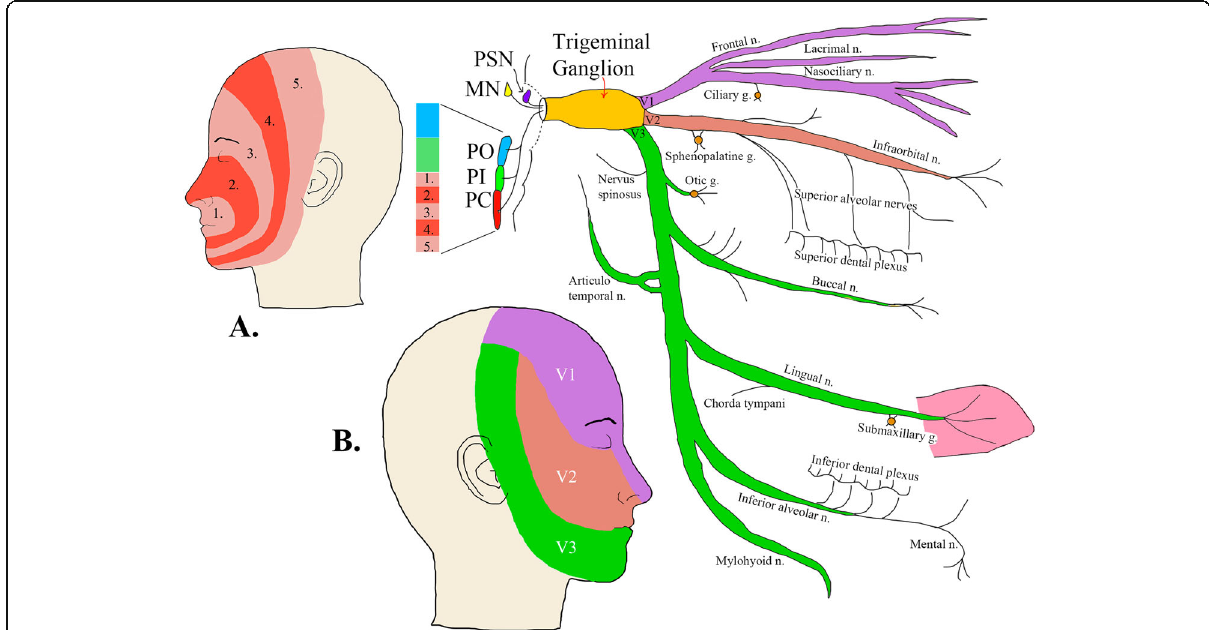
Fig. 1 Schematic of the Trigeminal System. a : The somatotopic distribution of trigeminal nociceptive afferents terminating in the trigeminal nucleus caudalis [11]. b : Innervation of facial skin areas and its related three branches (V1, V2 and V3). PSN (Principal sensory nucleus CN V), MN (Mesencephalic nucleus CN V), PA (Spinal nucleus of CN V Pars Oralis), PI (Spinal nucleus of CN V Pars Interpolaris), PC (Spinal nucleus of CN V Pars Caudalis). N. = Nerve. G. =